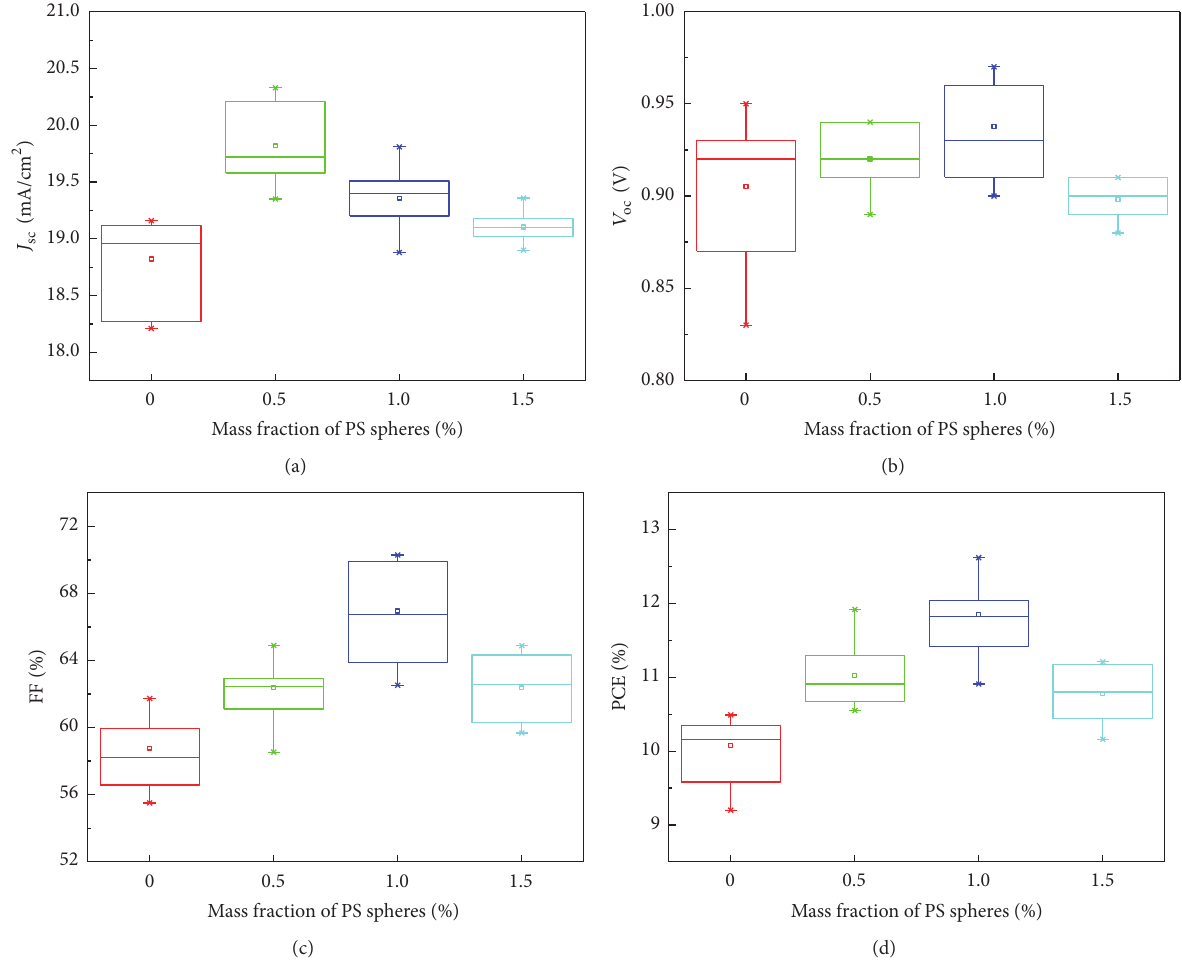
Figure 10: Statistic results of the cells based on the mp-TiO 2 film with different mass fractions of PS